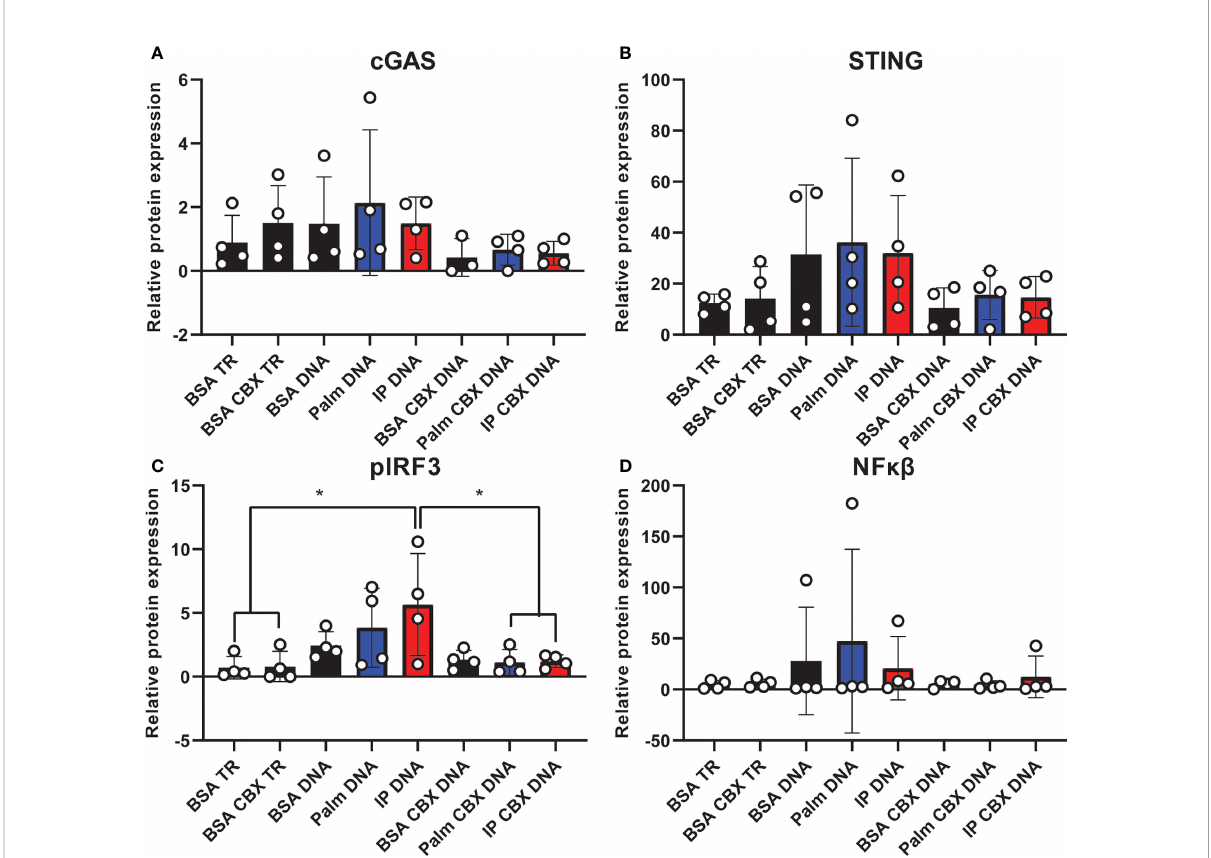
FIGURE 7 Co-culture cGAS/STING protein expression with and without gap junction inhibitor. Expression in a human hippocampal and human microglial cell line co-culture (n=4). Cells pretreated with bovine serum albumin (BSA; 31.25 µM, 24h) as a control, palmitate (Palm; 31.25 µM, 24h), or a combination of insulin and palmitate (IP; 31.25 µM palmitate and 50 nM insulin, 24h) +/- the gap junction inhibitor carbenoxolone (CBX; 150 µM), then stimulated with the dsDNA analog Poly dA:dT (DNA; 1µg/mL). Protein expression of cGAS (A) , STING (B) , pIRF3 (C) , and NF kb (D) quanti fi ed quanti fi ed as average band intensity relative to histone loading control; * p <0.05. TR, transfection